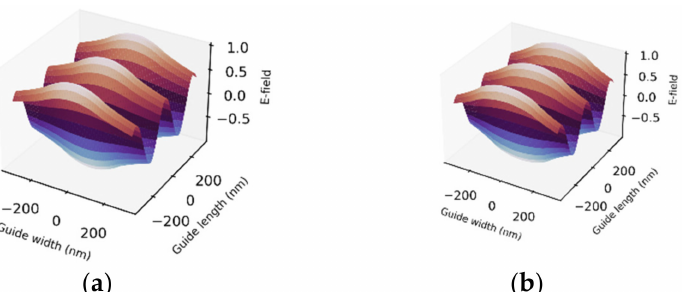
Figure 7. 3D normalized electric field profiles in PDMS–AAP buried waveguide of λ = 450 nm. Trans ( a ) and cis ( b ) support only single mode in 320 nm-thick core. Field remained invariant, but v number scaled up to 2.0 in cis